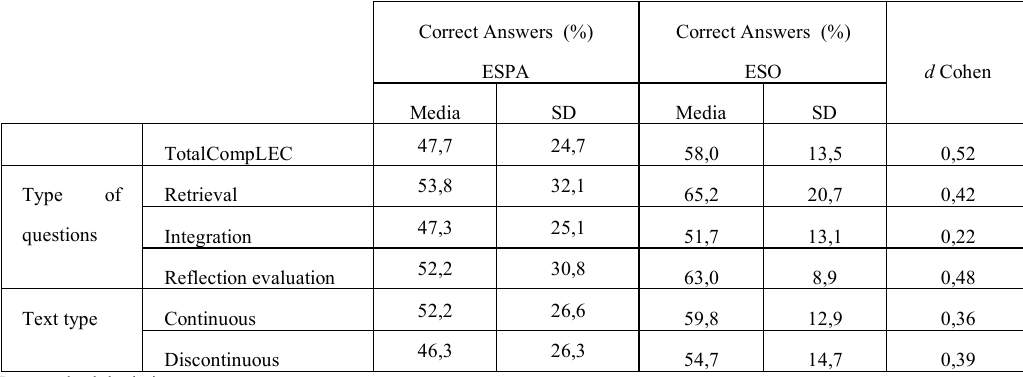
Table 3. Comparison of percentage of correct answers and effect size (Cohen’s d ) between the adult education sample and the normative sample using the CompLEC instrument (Llorens et al.,